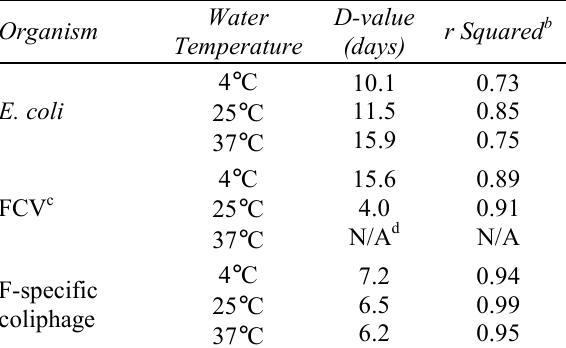
Table 2: D-values a and coefficient of variation of test organisms in tap water